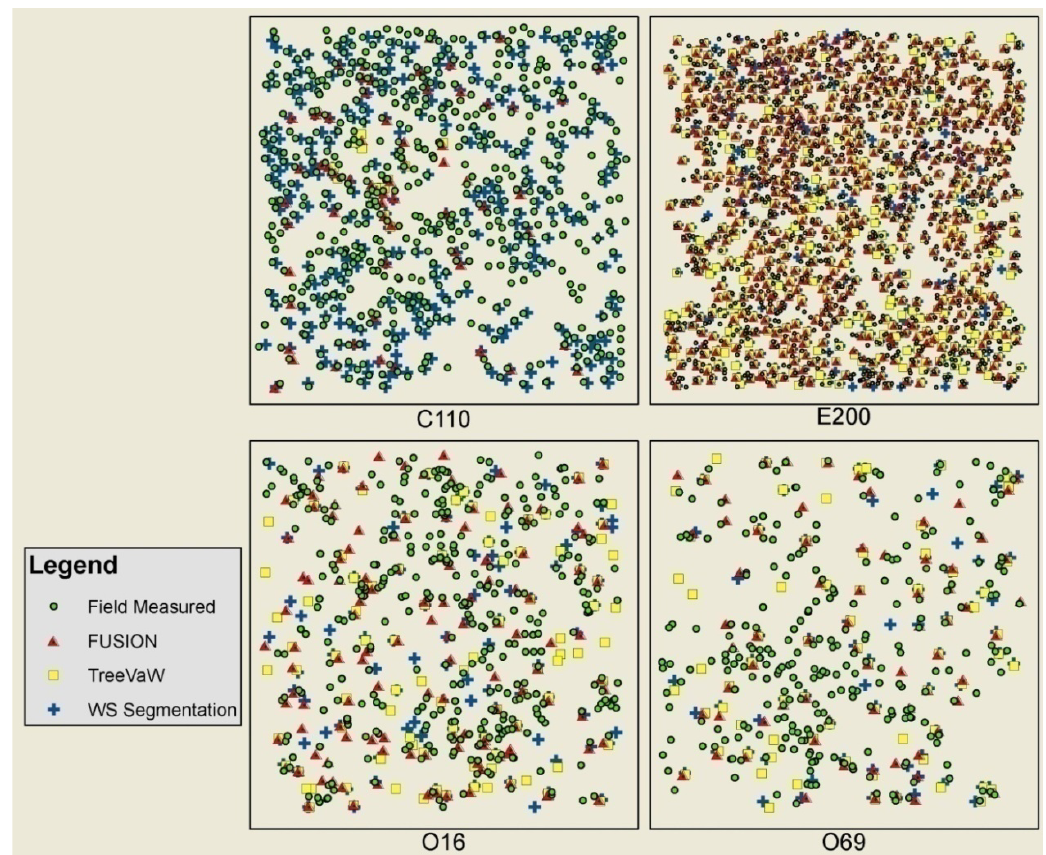
Figure 6. Plot maps of trees used for height comparisons of FUSION, TreeVaW and watershed segmentation matched trees and all field measured trees. Tree locations were measured by GPS in C110 and total station in all others. Plot E200 tree symbols are smaller than others to facilitate point differentiation detail and pattern based on the larger number of trees